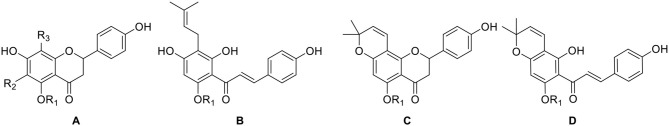
Structures of the prenylated flavonoids (A) Isoxanthohumol (R1=CH3, R2=H, R3=Prenyl), 8-Prenylnaringenin (R1=H, R2=H, R3=prenyl): 6-prenylnaringenin (R1=H, R2=Prenyl, R3=H). (B) Xanthohumol (R1=CH3). (C) Isoxanthohumol-C (R1=CH3). (D) Xanthohumol-C (R1=CH3).